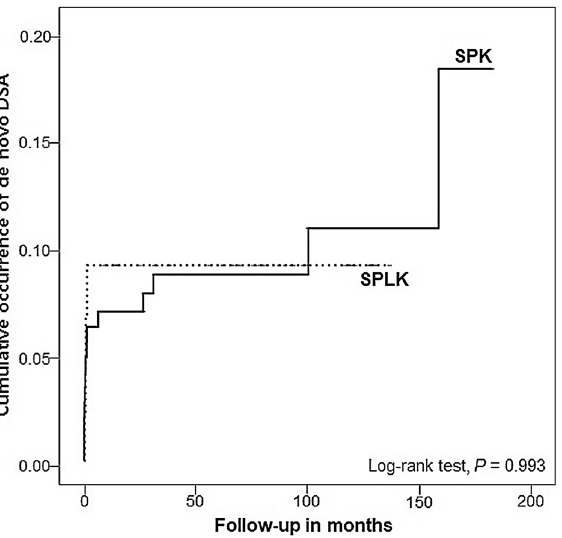
Figure 1. Presence of detectable de novo DSA in the study groups during follow-up. P -values were obtained by log-rank test statistics pairwise over